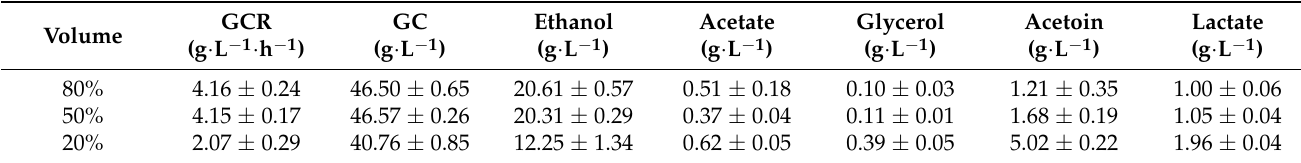
Table 2. Fermentation profiles of Z. mobilis under different conditions. GCR: Glucose consumption rate, GC: Glucose consumed. Strains were cultured in 100-mL shake flakes at 30 ◦ C, 100 rpm. Mean values for triplicate repeats are shown for each condition ± standard